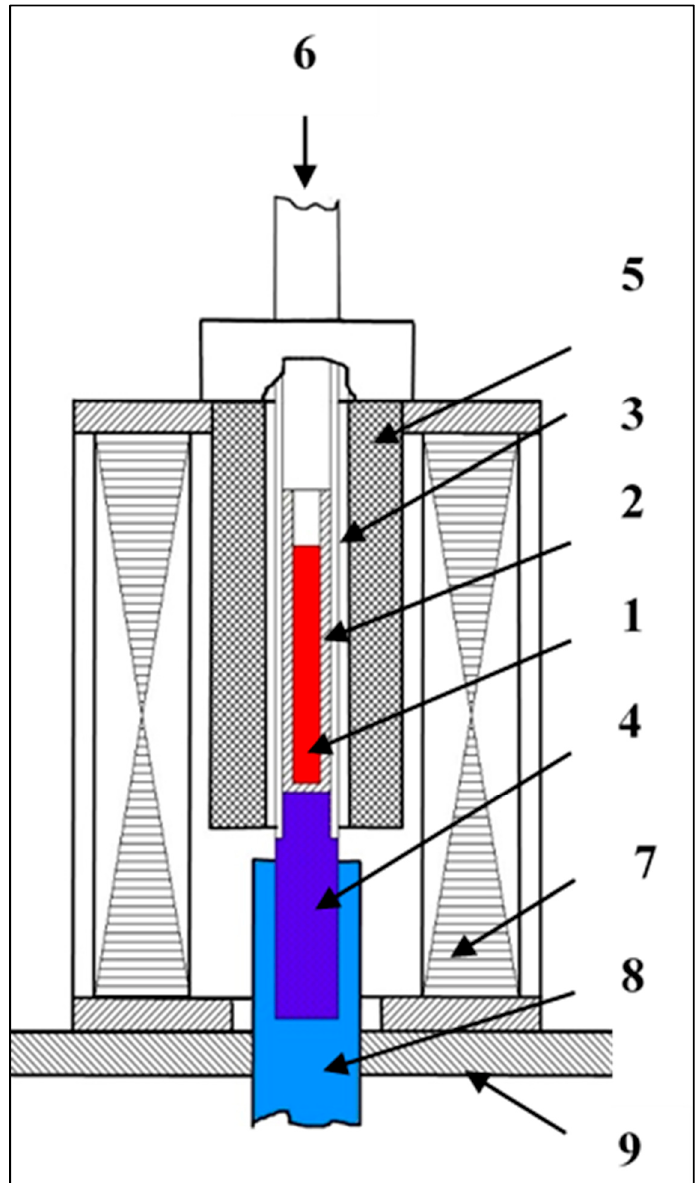
Figure 2. Sketch of solidification facility; 1: Sample, 2: alumina capsule, 3: quartz tube, 4: copper cooling core, 5: furnace with four heating zones, 6: step motor, 7: RMF inductor, 8: water cooling,